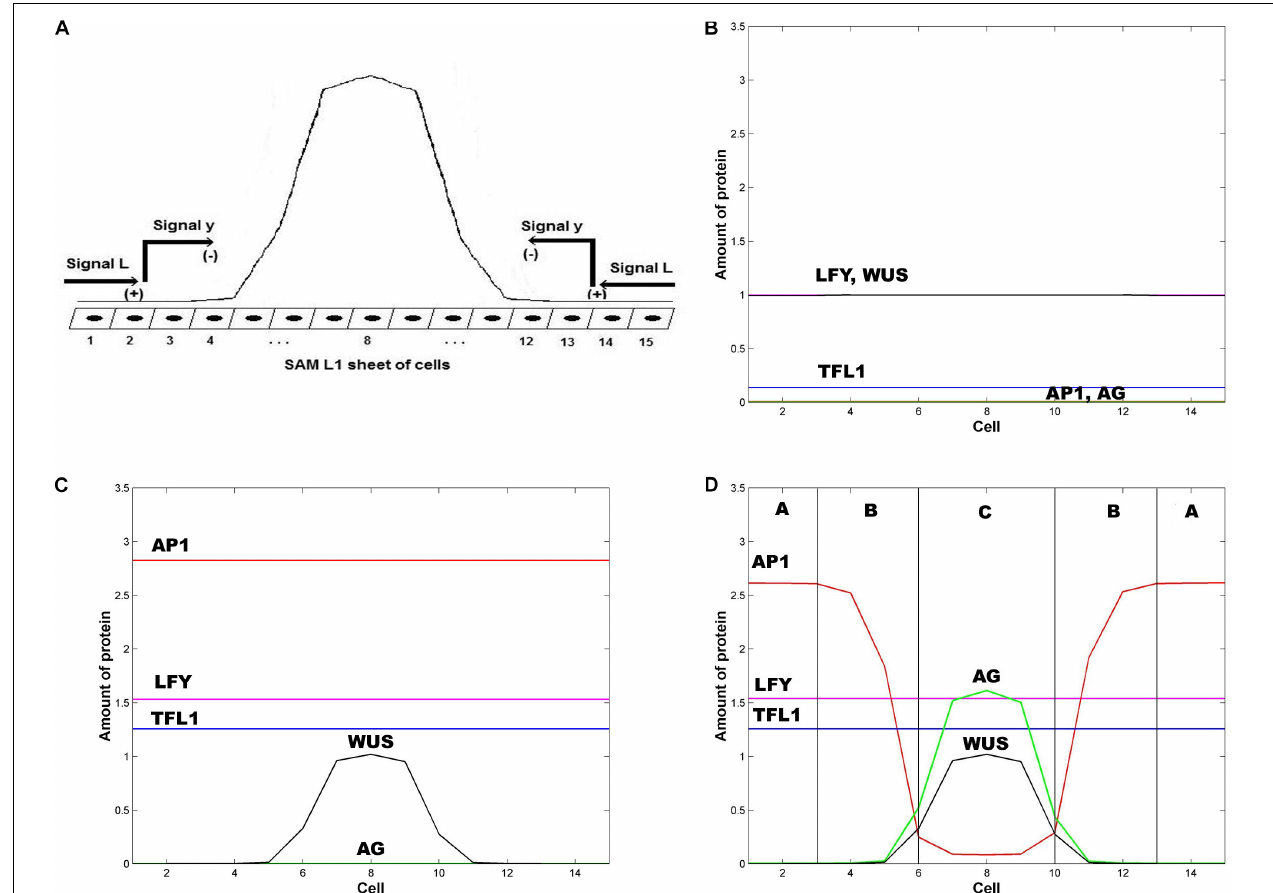
FIGURE 2 | Emergence of the ABC zones of flower organ determination. (A) WUS pre-pattern is the result of the action of the inhibitory signal L from the extremes of the SAM L1 sheet that induces the activation of the inhibitory chemical signal y that restricts WUS expression to the inner whorl of the floral meristem. In the model we represent the floral meristem as a linear array of 15 cells that crosses the diameter of the four whorls. (B) Initial homogeneous spatial distribution of the chemical fields at the beginning of the simulation, LFY (red line), TFL1 (yellow line), AP1 (brown line) AG (black line), and WUS (blue line); (C) WUS pattern (blue line) arises at the center of the floral meristem after ∼ 1 h; and (D) the initial homogenous state of the floral meristem is completely broken after ∼ 16 h. AG is expressed at the center of the meristem (black line) and its presence moves AP1 away from this zone. In consequence, the floral meristem has been patterned into three well defined zones of gene expression. In all Figures ε = 5. In all panels L (1) = L (2) = L (3) = L (13) = L (14) = L (15) = 1, and L (j) = 0 for 4 ≤ j ≤ 12; in similar form: y (1) = y (2) = y (3) = y (13) = y (14) = y (15) = 1, and y (j) = 0 for 4 ≤ j ≤